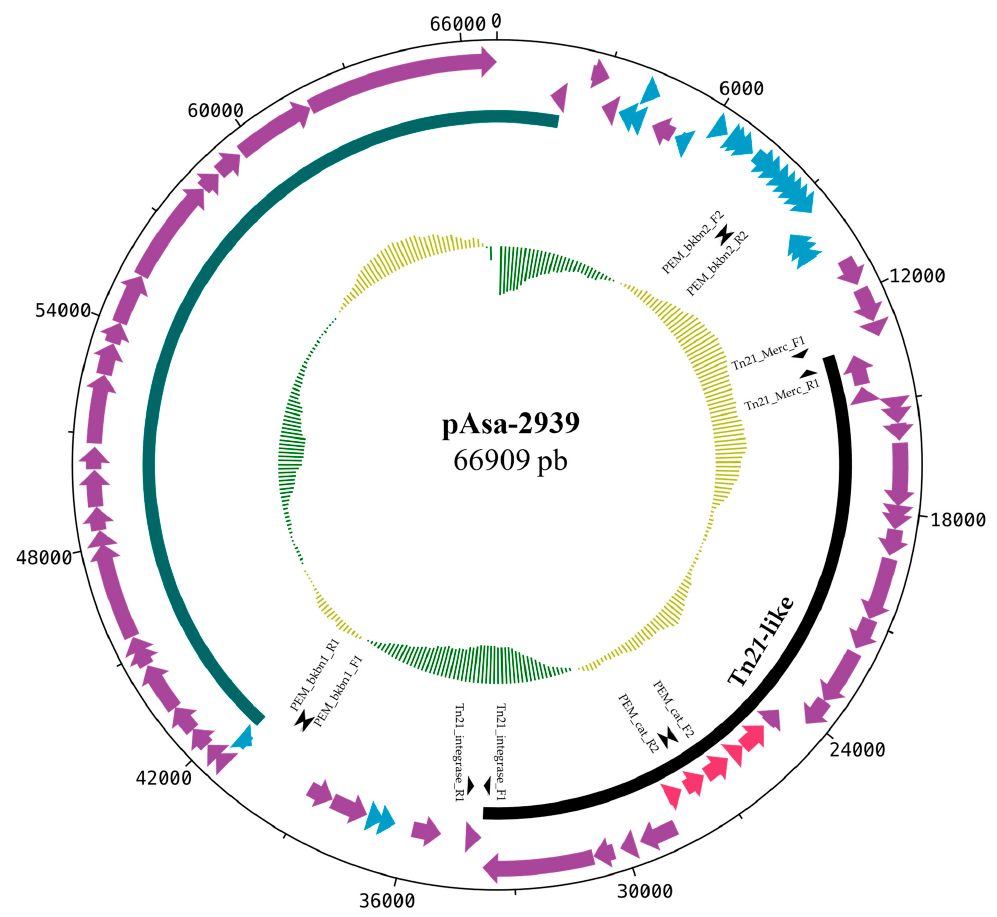
Figure 1. Gene map of the pAsa-2939 plasmid. This map was produced with the DNA plotter software. The red genes code for antibiotic resistance proteins, the blue genes for hypothetical proteins, and the purple genes for proteins with other known functions. The black arc indicates the transposon (Tn 21 -like). The green arc corresponds to conjugation genes and the inner circle corresponds to the GC skew. The primers used for PCR genotyping are also shown on the map with